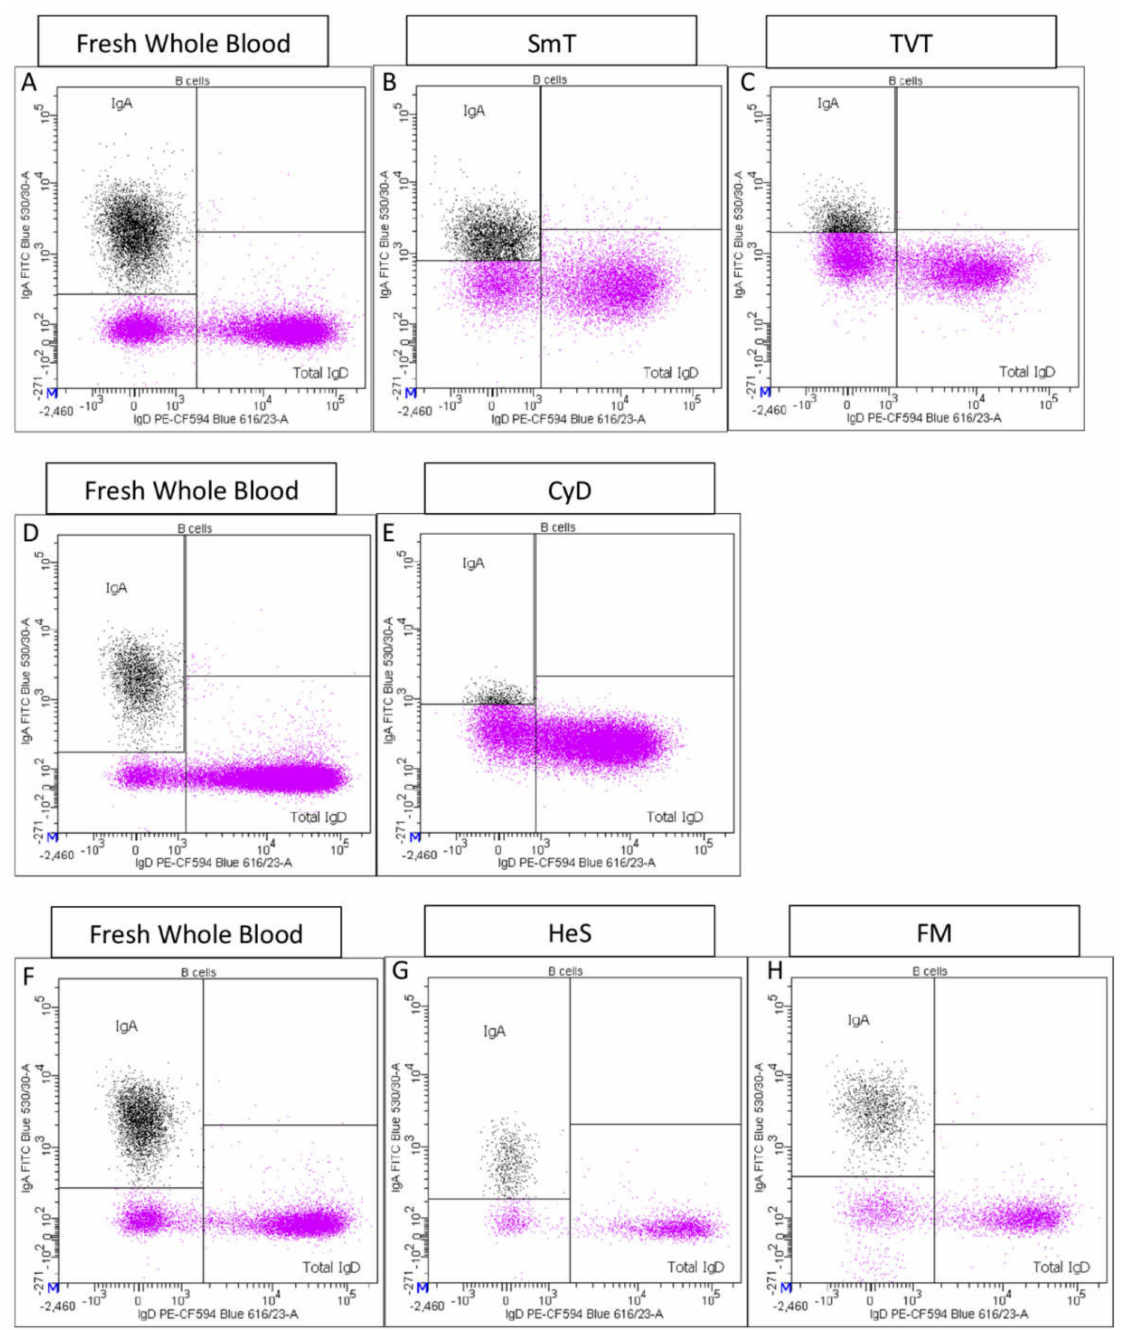
Figure 3. Representative IgA staining of fresh whole blood and thawed samples. The corresponding fresh whole blood is shown on the same line for each freezing method: fresh sample ( A ) is the control for SmT ( B ), and TVT ( C ) methods; fresh sample ( D ) is used as the control for CyD ( E ) method, and fresh sample ( F ) for HeS ( G ) and FM ( H )